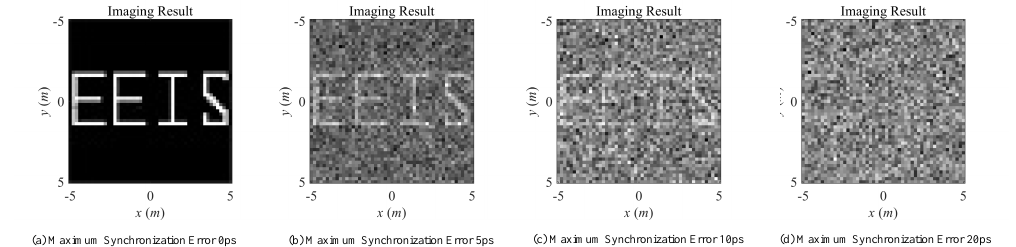
Figure 9. Imaging results with different levels of synchronization